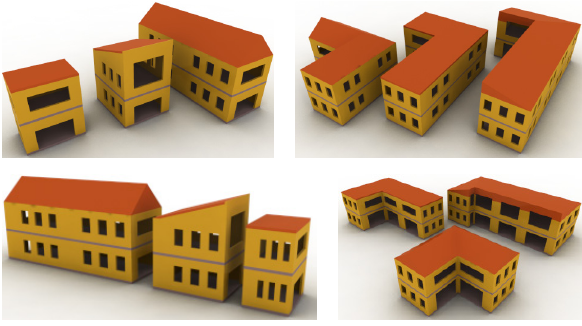
Figure 7: Residential rectangular and L-shapes